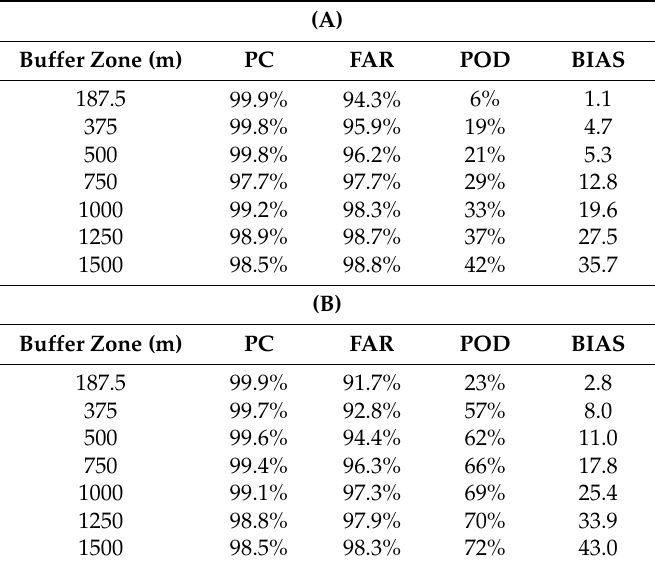
Table 8. ( A ) The scores of PC, FAR, POD, and BIAS of VNP14IMG compared with ToPeCAl with a different time of 3 hours in day-time, and ( B ) a combination of 3 hour and 15 hours difference in time. The calculations were generated for buffer zones of 187.5 m to 1250